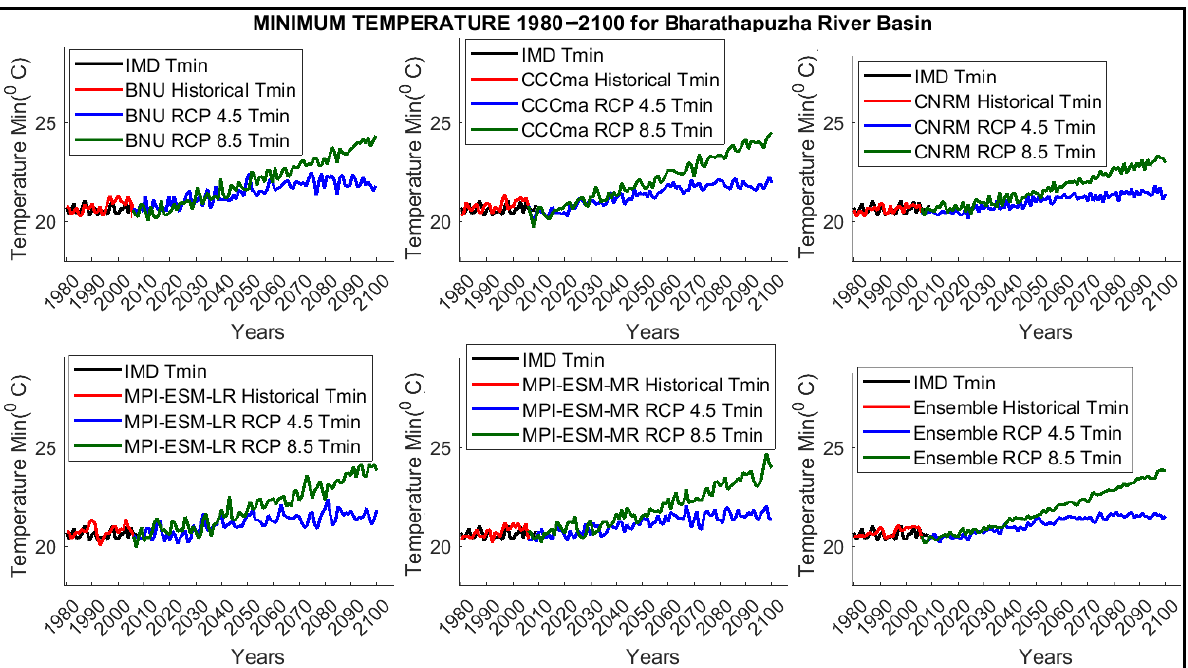
Figure 6. Comparison of observed and GCMs simulated maximum temperature during historical (1981 to 2010) and future periods (2011 to 2100).